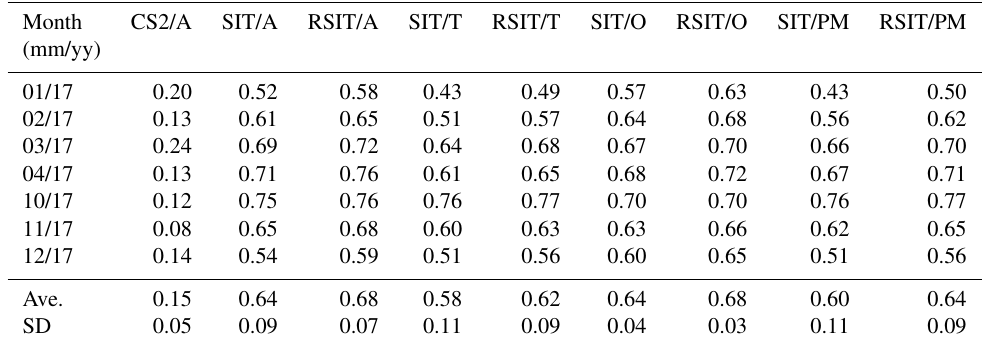
Table 1. Monthly average cross-correlations between the SIT estimates studied with respect to the reference data set SIT. SIT refers to the proposed algorithm SIT, RSIT refers to the proposed algorithm SIT with remapping based on the histogram mapping with model data, CS2 refers to the CS2 values assigned to the SAR segments (without inter- or extrapolation), A refers to the SIT derived from the AARI ice charts, T refers to the TOPAZ4 model reanalysis SIT, and O refers to the ORAS5 model SIT.